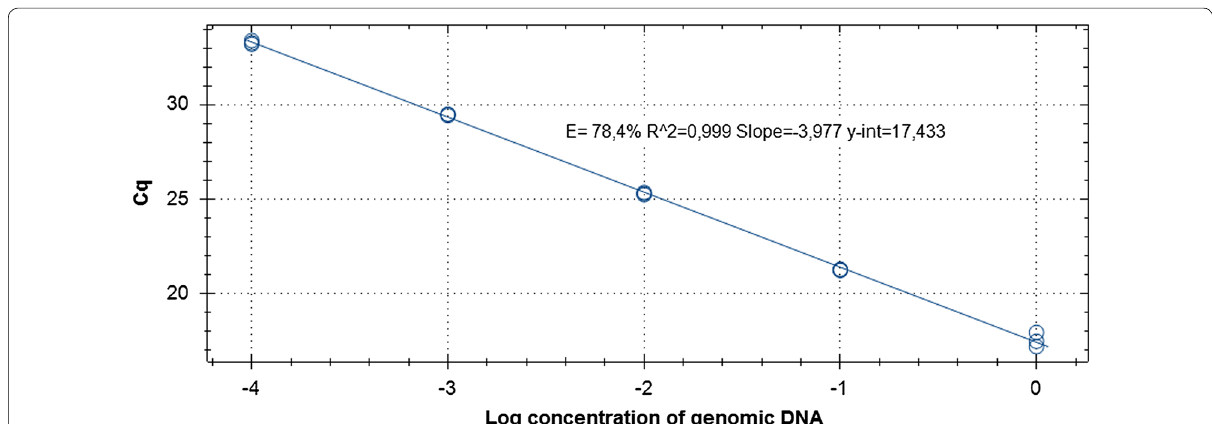
Fig. 4 The dependence of Cq parameter on concentration of genomic DNA of P.